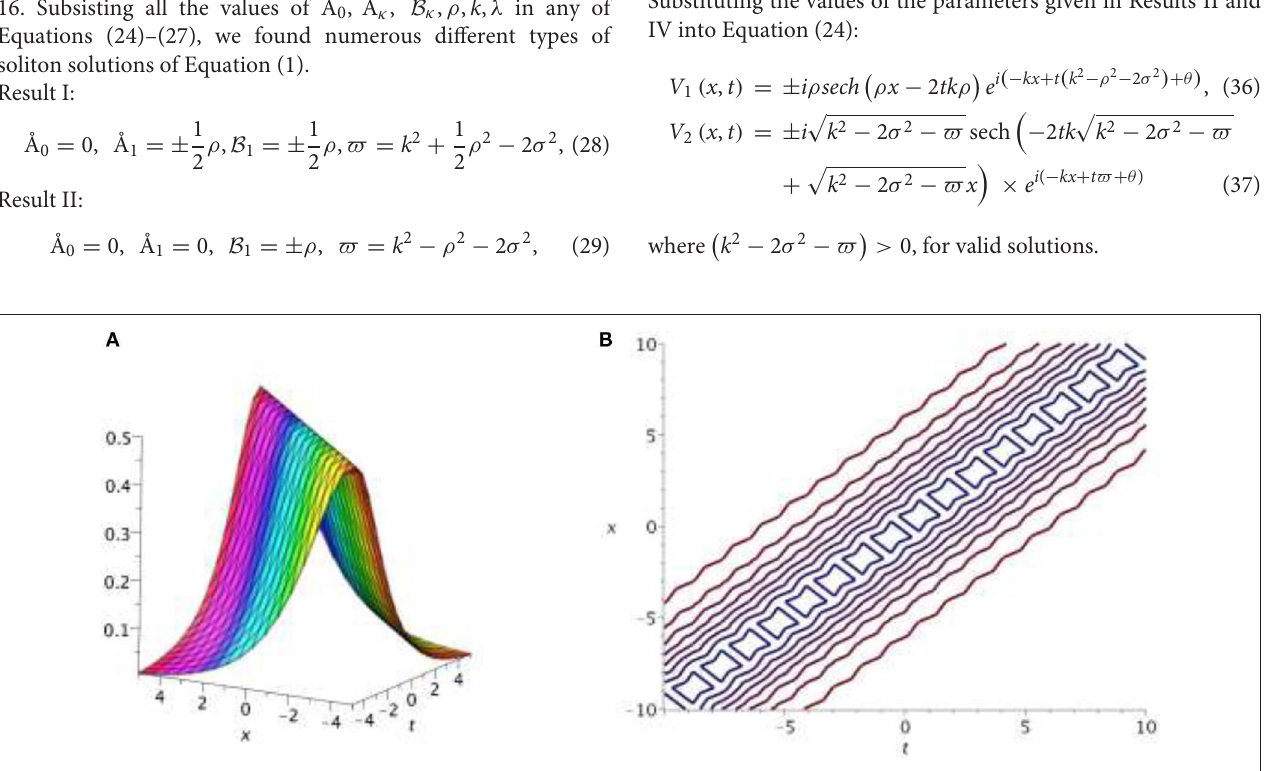
FIGURE 1 | (A) Bright soliton Equation (36). (B) Contour plot.